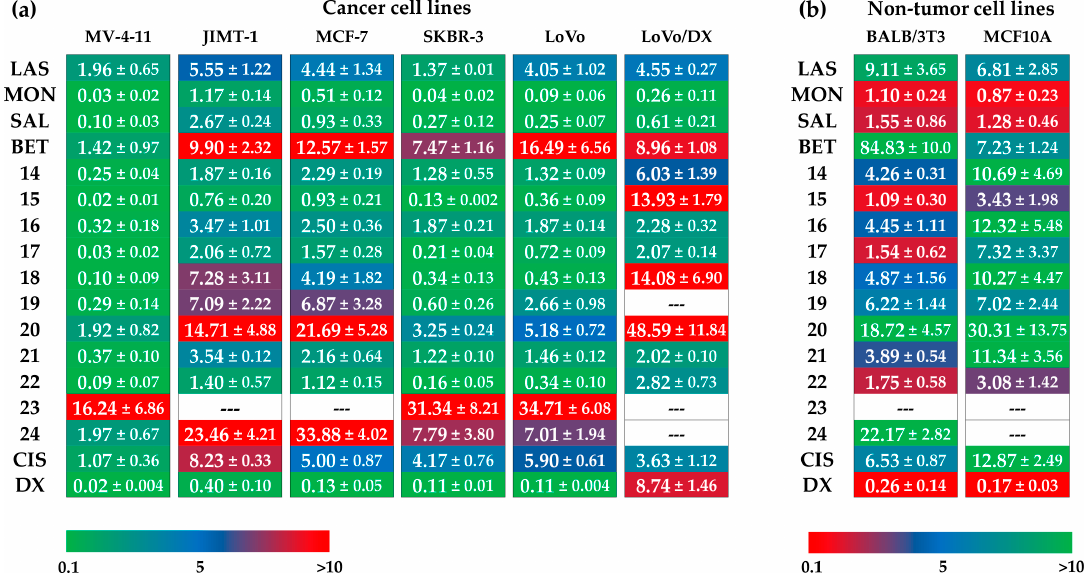
Figure 2. Antiproliferative activity of tested compounds against ( a ) cancer cell lines, and ( b ) non-tumor cell lines, where LAS , MON , and SAL = sodium salt of lasalocid acid, monensin, and salinomycin, respectively, BET = betulinic acid, CIS = cisplatin, and DX = doxorubicin. Data are given as IC 50 in µM (mean ± SD).